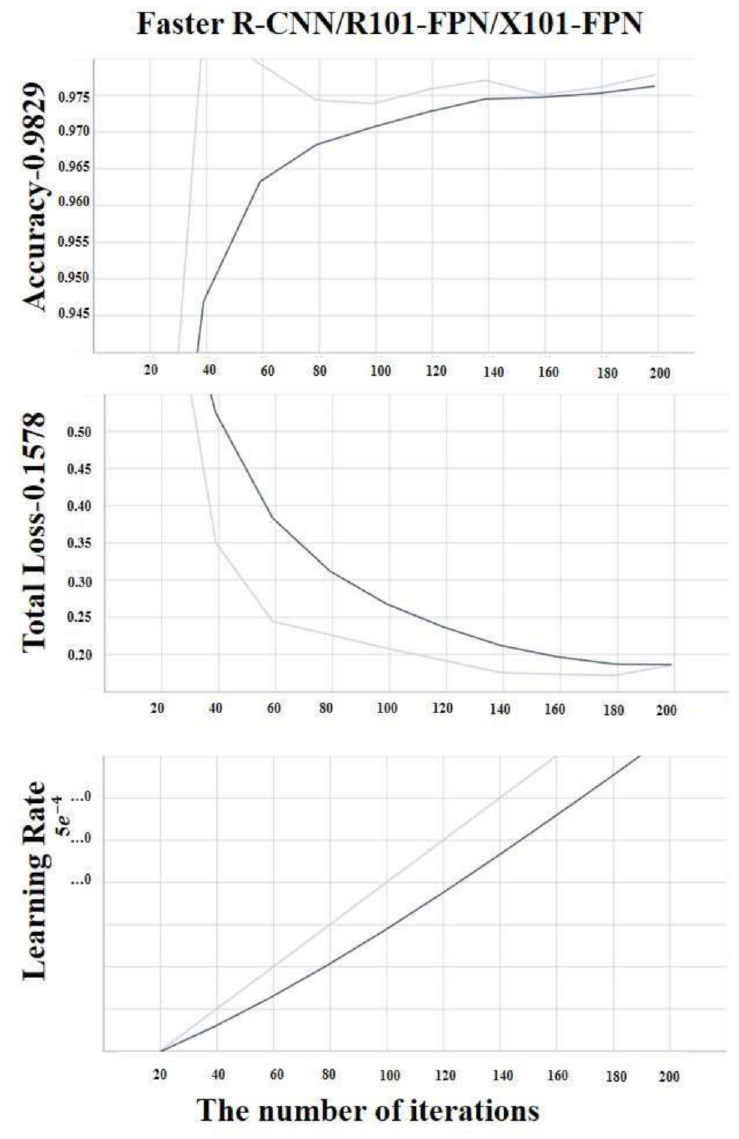
Figure 5. Model result values of both backbone